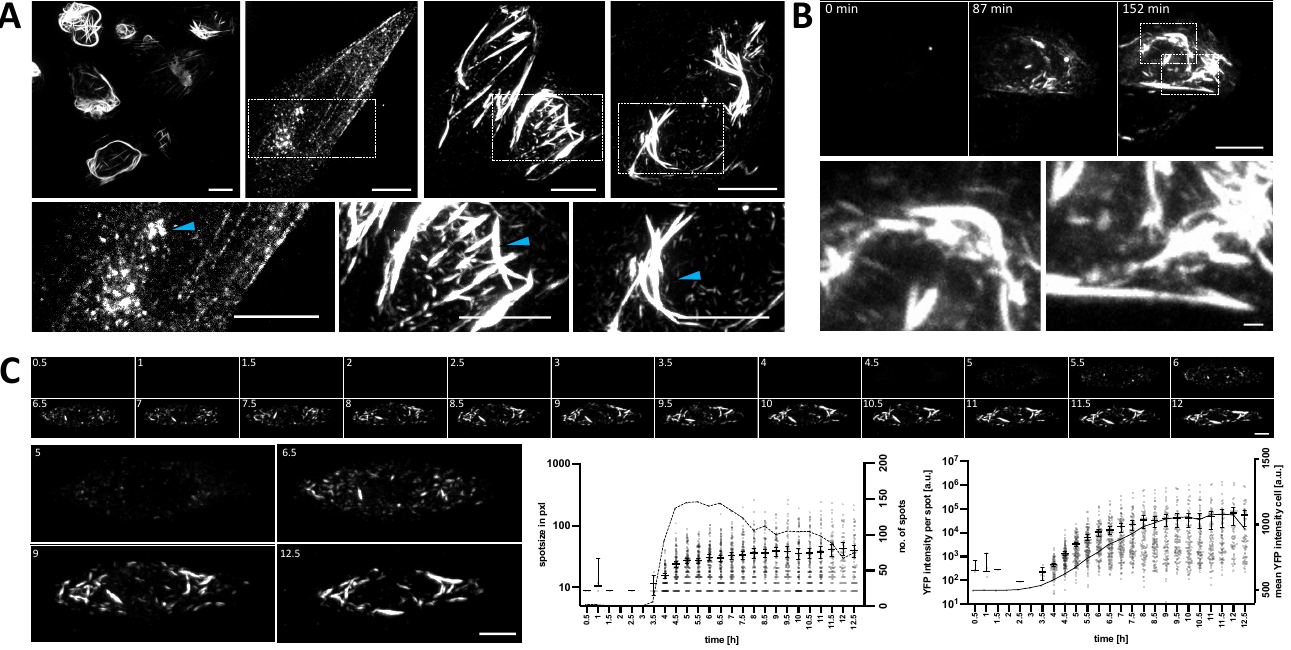
Figure 1. Heterogeneity and dynamics of YFP-N expression patterns. ( A ) CHO-K1 cells were transfected with YFP-N for 24 h and observed via confocal spinning disk microscopy. Transfected cells show highly diverse and heterogenous distributions of YFP-N throughout most of the cell body. The image on the upper left shows an overview of multiple cells. Individual examples are shown on the right and magnifications of the boxed areas are displayed at the bottom of the panel. Blue arrows highlight specific protein aggregation states (punctate, spikes, and arch-like tubules). ( B ) The dynamics of YFP-N assemblies were observed by live time-lapse microscopy over several hours post transfection. Three time points are shown in the upper panel. The two boxed areas at 152 min are shown magnified in the lower panel (Scale bar: 1 µ m). ( C ) Representative cell (top panel), repeatedly imaged for 12.5 h post transfection. Each individual micrograph shows the same cell, imaged in 30-min intervals. Another panel (bottom left) displays magnifications of four selected time points as indicated on the images. The graph on the on the bottom right shows size and fluorescence intensity of single protein aggregates plotted over time (grey dots, see SI Figure S1B for additional examples). Protein aggregates were identified by automated image analysis using the ImageJ plugin ComDet. Bars show the mean with 95% confidence interval. The solid lines indicate the overall mean YFP intensities of the entire cell, whereas the dashed line shows the overall number of detected spots (both plotted on right Y-axes). All micrographs show maximum intensity projections of z-stacks. If not otherwise stated scale bars: 10 µ